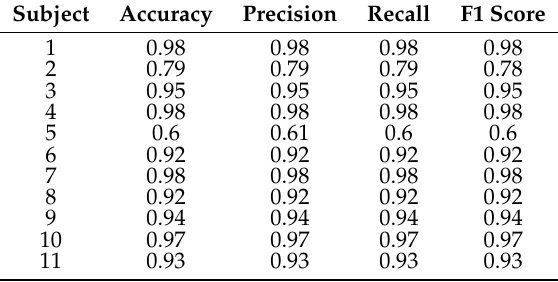
Table 3. Classification accuracy, precision, recall, and F1 score values for 11 subjects produced by the DQN